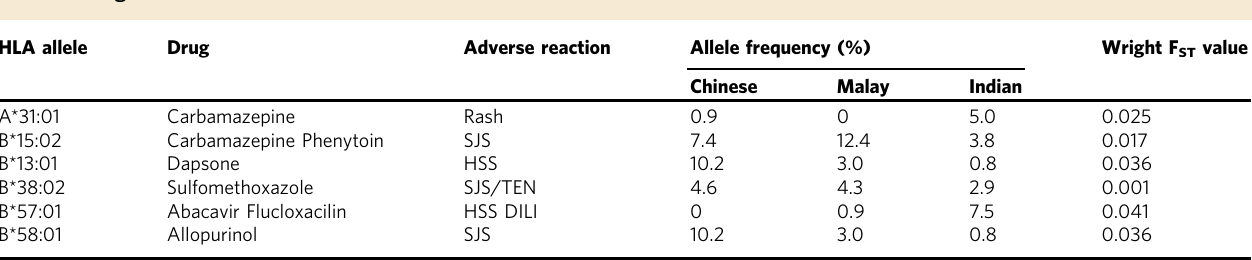
Table 3 Drug-associated HLA